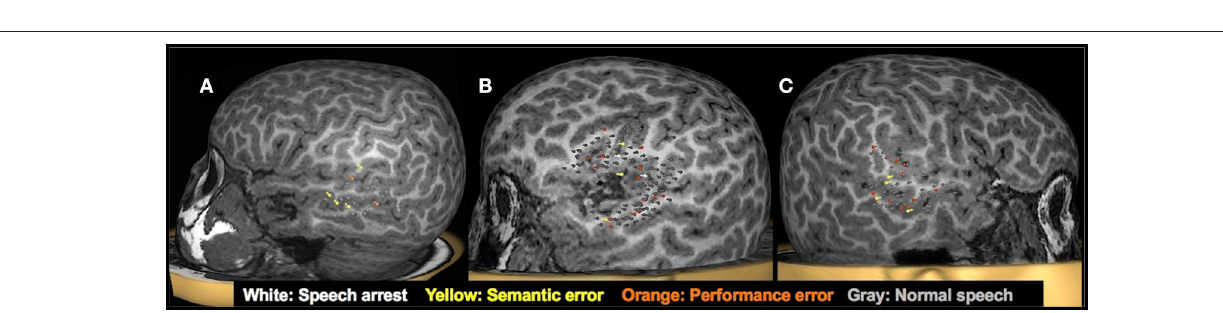
FIGURE 7 | Clinical utility of presurgical TMS-derived language mapping in preschool children with brain tumors. (A) : Left hemisphere temporal lobe language mapping in a 5.3-year-old female with recurrent pilomyxoid astrocytoma. She underwent a left temporal microsurgical subtotal (70%) tumor resection. Post-operatively, she had no speech deficits. (B) : TMS language map from a 5-year-old male with recurrent left sylvian anaplastic ependymoma. Critical language areas were found around the margin of the tumor. The tumor was resected in full without any postoperative language deficits. (C) Right hemisphere temporal lobe language mapping in a 5.9-year-old female with a lesion in the right temporal lobe. Critical language areas were identified in bilateral temporal lobes. She underwent a resection of the right anterior temporal lobe, right amygdala, and hippocampus. The pathology classified the specimen as grade I ganglioglioma and focal cortical dysplasia type IIIb. Post-operatively, she had no speech